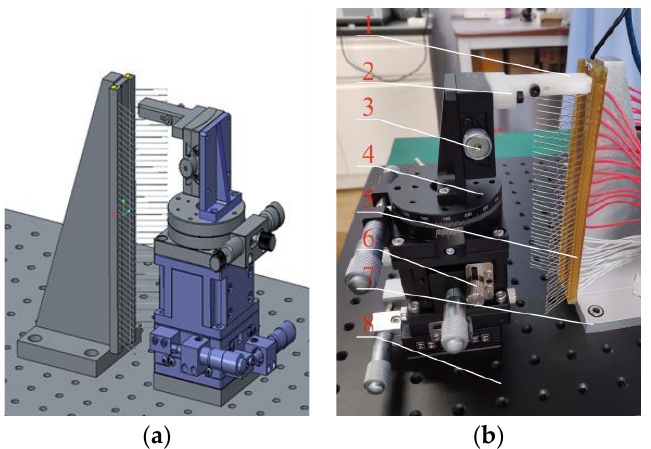
Figure 1. Design of the brush wire forming device. ( a ) Three-dimensional diagram of the brush wire angle forming device; ( b ) Brush wire angle forming device.